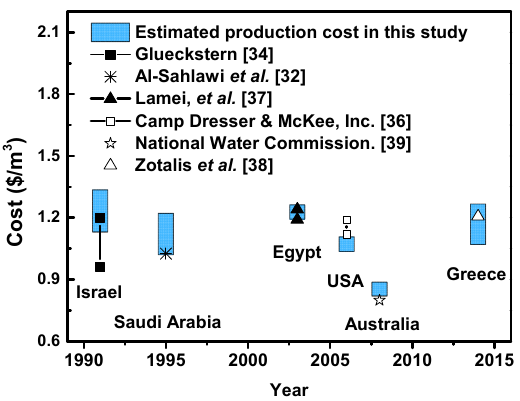
Figure 2. Validation of the estimated unit production costs in this study (blue bar, maximum to minimum values) based on comparisons with values from previous studies (dispersed points).